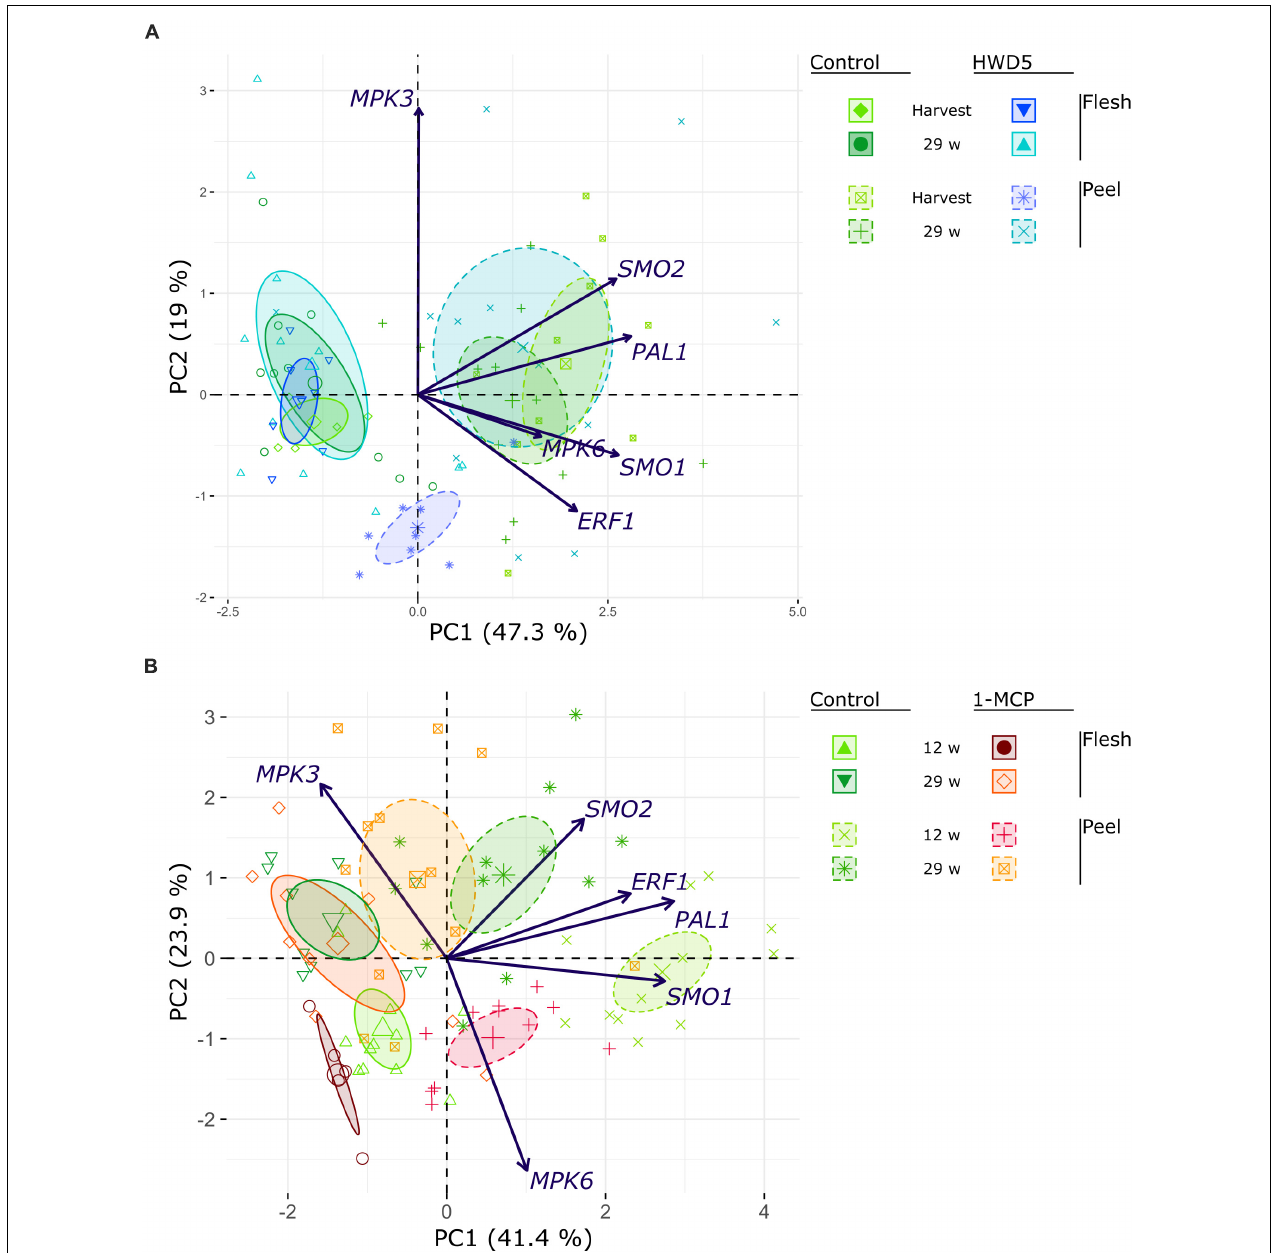
FIGURE 8 | PCA biplot of gene expression analyses performed on (A) control and HWD5 at harvest or after 29 w of CA storage, or (B) control and 1-MCP treated apples that had been stored with CA 13 or 29 w. Ellipses denote 95% confidence